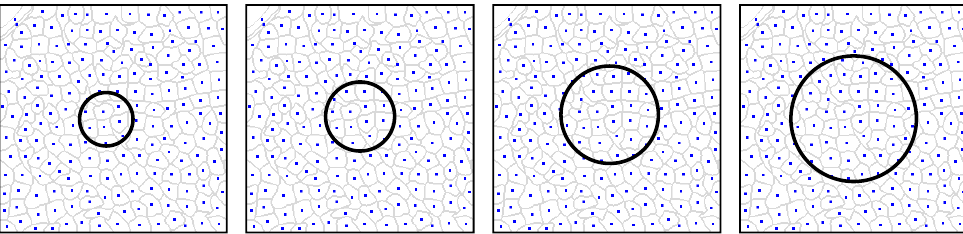
Figure 7. Semantic range. Circles of different radii are used to define the semantic range, which contains segmented objects for